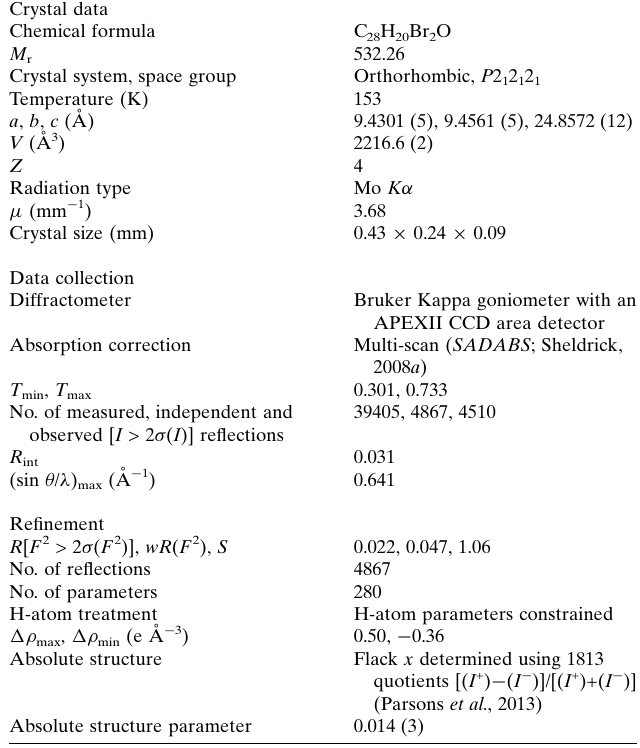
Table 2 Experimental details.